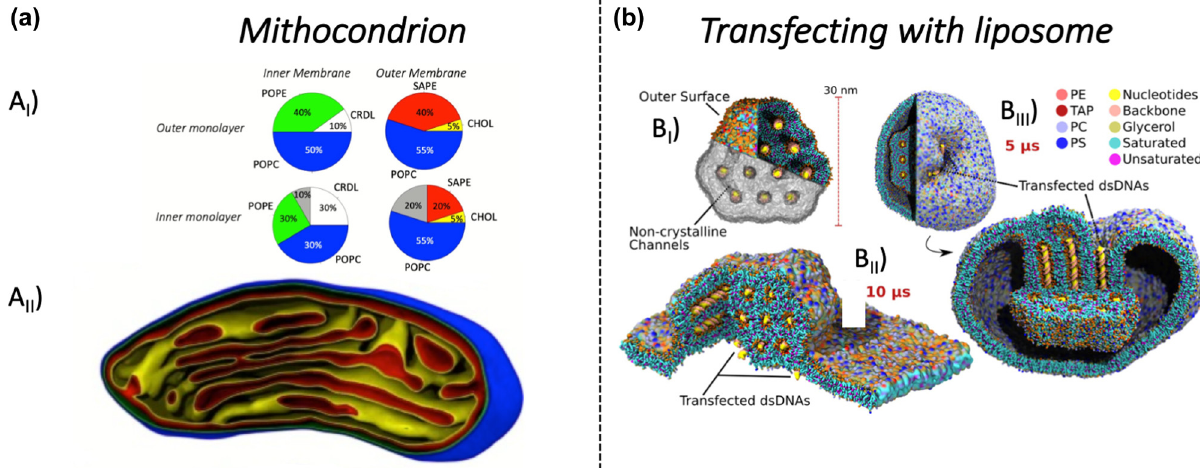
Figure 7: MD of large organelles. ( a ) Modeling scheme of mitochondrial membrane at near - atomic resolution. ( Ai ) Composition of mito - chondrial membrane. POPC, 1 - palmitoyl - 2 - oleoyl - sn - glycero - 3 - phosphocholine; POPE, 1 - palmitoyl - 2 - oleoyl - sn - glycero - 3 - phosphoethano - lamine; SAPE, 1 - stearoyl - 2 - arachidonoyl - sn - glycero - 3 - phospho - ethanolamine; SAPI, 1 - stearoyl - 2 - arachidonoyl - sn - glycero - 3 - phosphoino - sitol; CHOL, cholesterol; CRDL, cardiolipin. ( Aii ) Cross - section of the generated surface points for the outer monolayer of outer membrane ( blue ) , inner monolayer of outer membrane ( green ) , outer monolayer of inner membrane ( red ) , and inner monolayer of inner membrane ( yellow ) . Figures ( Ai ) and ( Aii ) have been adapted from Pezeshkian et al . [ 288 ] . ( b ) MD simulation of transfection using large lipoplexes. ( Bi ) Schematic structure of large lipoplex, showing connecting channels. ( Bii ) Snapshot of MD trajectory, showing the fusion of lipoplex on top of a large endosomal model bilayer patch. ( Biii ) Last stage of dsDNA transfection: release of dsDNA from large lipoplex. Figures ( Bi ) , ( Bii ) , and ( Biii ) have been adapted from Bruininks et al . [ 314 ] , with the permission of eLife Sciences Publications